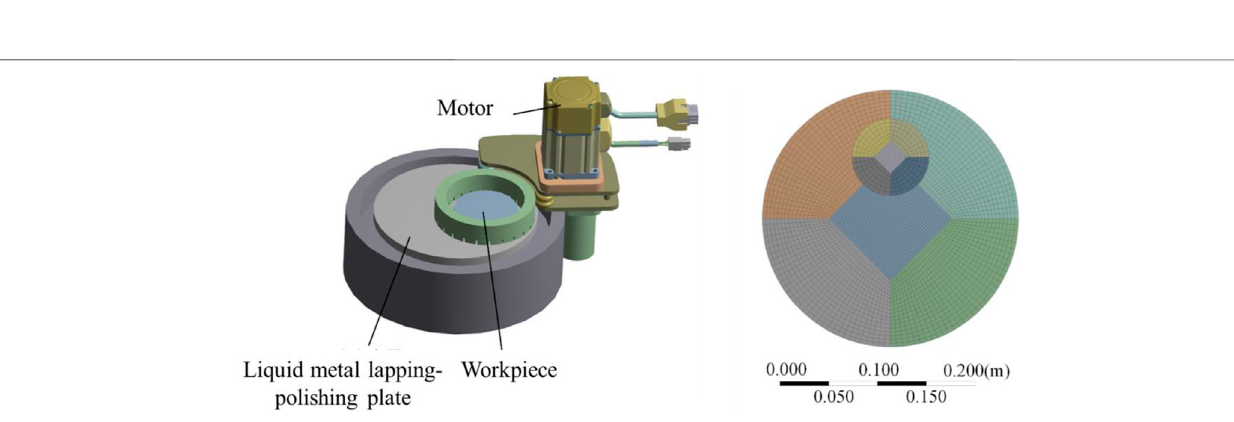
FIGURE 2 | Model geometry and meshing generation.